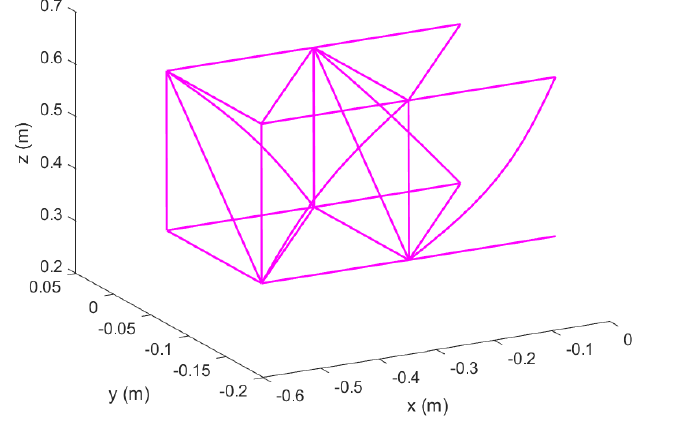
Figure 43. Mode 4 of Timoshenko beams in Topology 2 with hinged ends; original configuration.